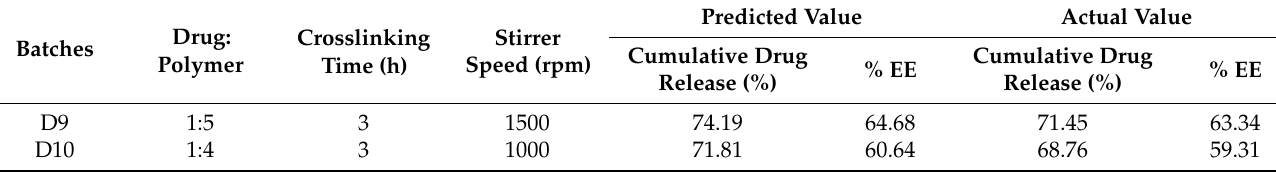
Table 4. Predicted and actual cumulative drug release (%) and entrapment efficiency (%) values of the checkpoint batches.